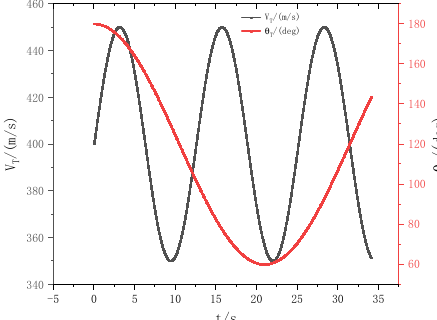
Figure 6. The maneuver characteristics of the Figure 6. T he maneuver characteristics of the target.